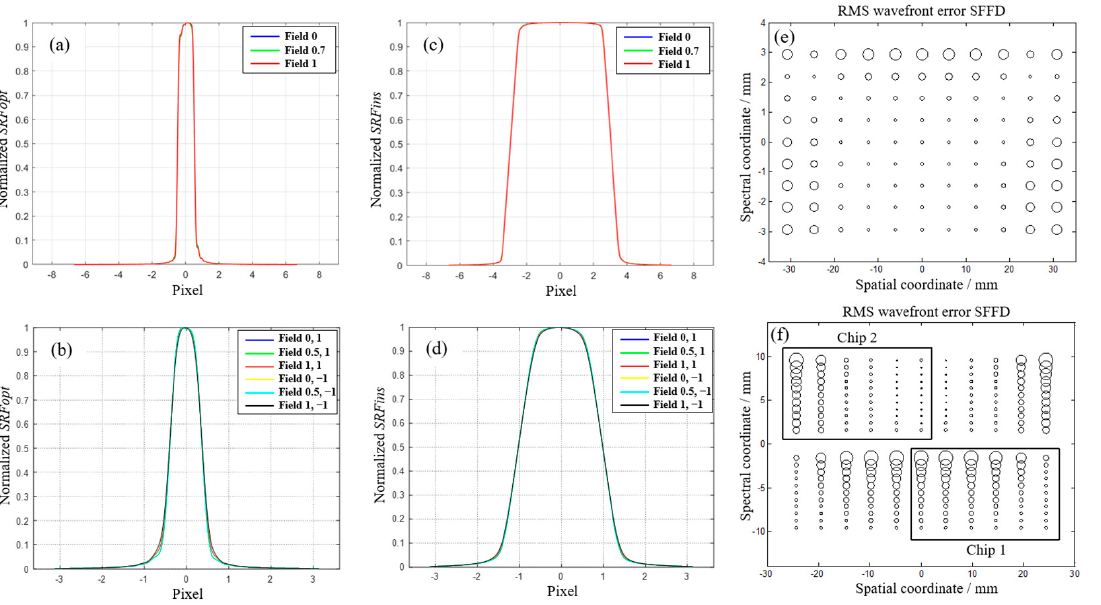
Figure 8. ( a ) SRF opt of B1 at 0.43 μ m; ( b ) SRF ins of B1 at 0.43 μ m, detector samples with 6× pixels (pixel size 15 μ m) binning; ( c ) SRF opt of B3 at 1.75 μ m; ( d ) SRF ins of B3 at 1.75 μ m, detector samples with 2× pixels (pixel size 32 μ m) binning; ( e , f ) SFFDs of B1 and B3 spectrometers.